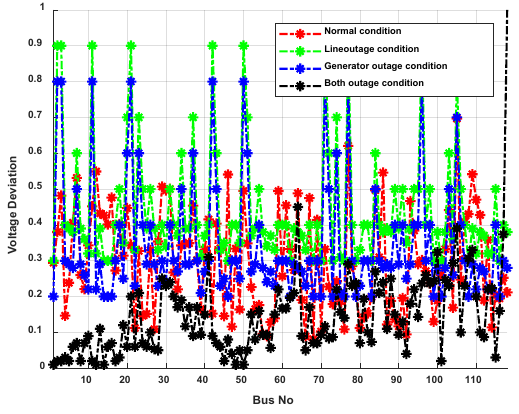
Figure 14. Analysis of Voltage deviation